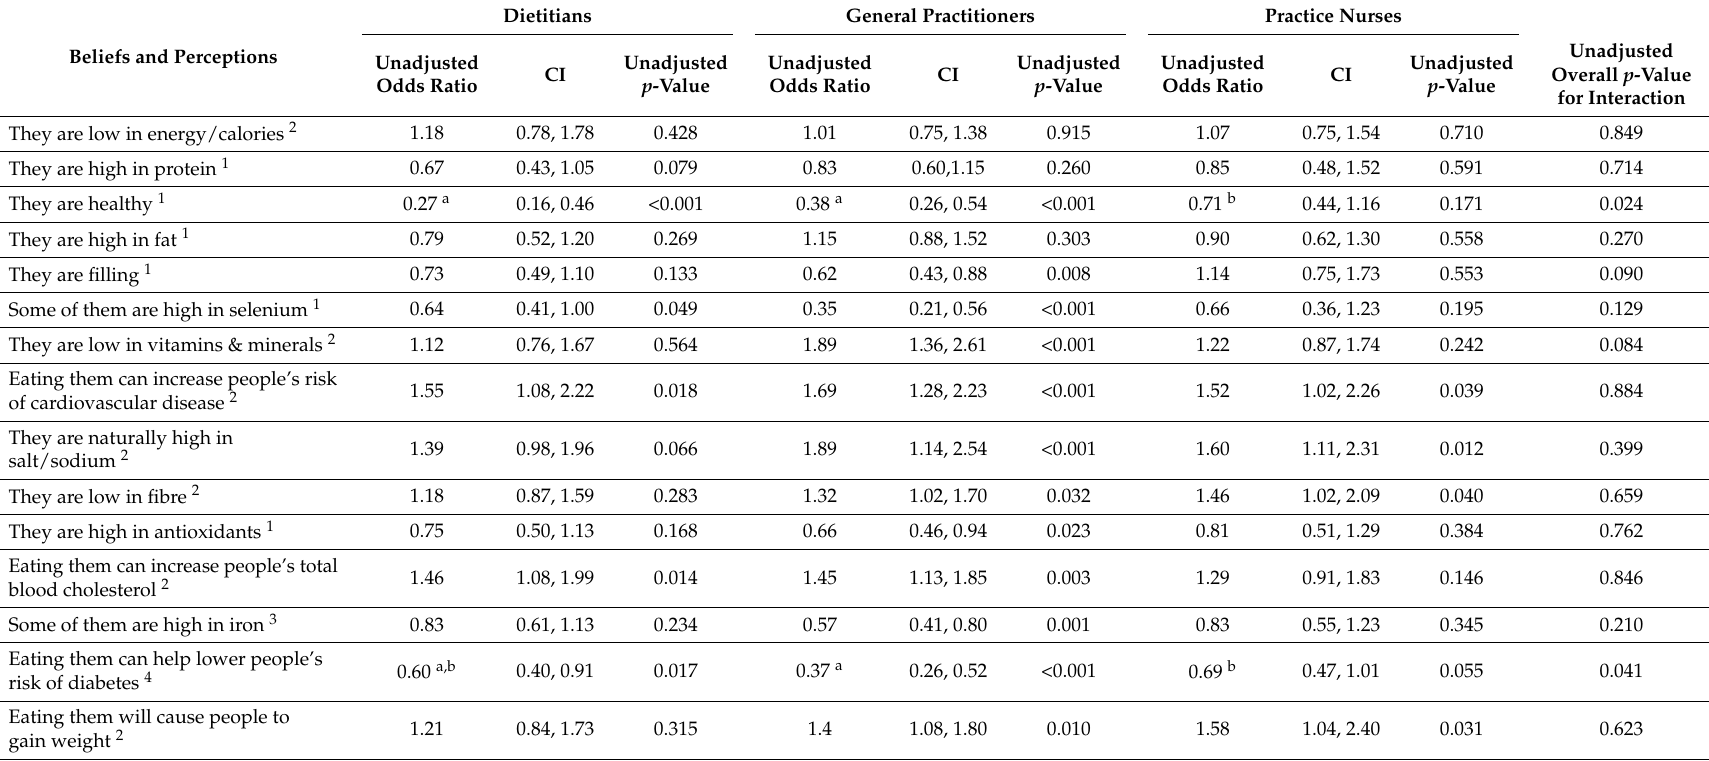
Table 6. Associations between beliefs/perceptions and recommending